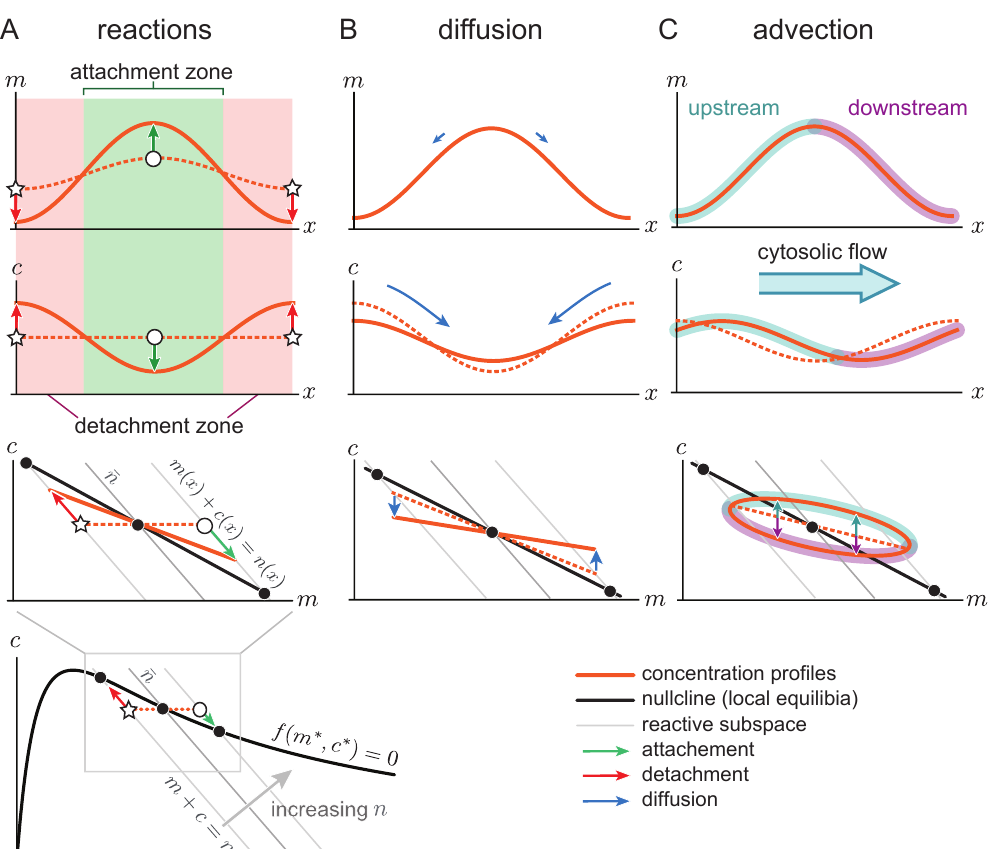
Figure 3. Sketch of the initial dynamics of an laterally unstable spatially homogeneous steady state. The role of reactions ( A ), diffusion ( B ), and advection ( C ) for a mass-redistribution instability are presented for the membrane (top) and cytosolic (middle) concentration profiles and in phase space (bottom). ( A ) A small perturbation of the spatially homogeneous membrane concentration (orange dashed lines in top panel) leads to a spatially varying local total density n ( x ) , with a larger total density at the maximum of the membrane profile (open circle) and a smaller total density at the minimum (open star). These local variations in total density lead to attachment zones (green region) and detachment zones (red region). The reactive flow, indicated by the red and green arrows, points along the reactive subspace (gray lines) in phase space towards the shifted local equilibria (black circles). These reactive flows lead to the solid orange density profiles after a small amount of time. ( B ) Faster diffusion in the cytosol compared to the membrane (indicated by the large and small blue arrows in the middle and top panel, respectively), lead to net mass transport from the detachment zone to the attachment zone. Again, dashed and solid lines indicate the state before and after a short time interval of diffusive transport. ( C ) Cytosolic flow shifts the cytosolic concentration with respect to the membrane concentration (orange dashed to orange solid lines), increasing the cytosolic concentration on the upstream side of the pattern and decreasing the cytosolic concentration on the downstream side. In phase space, the trajectory of this density profile forms a